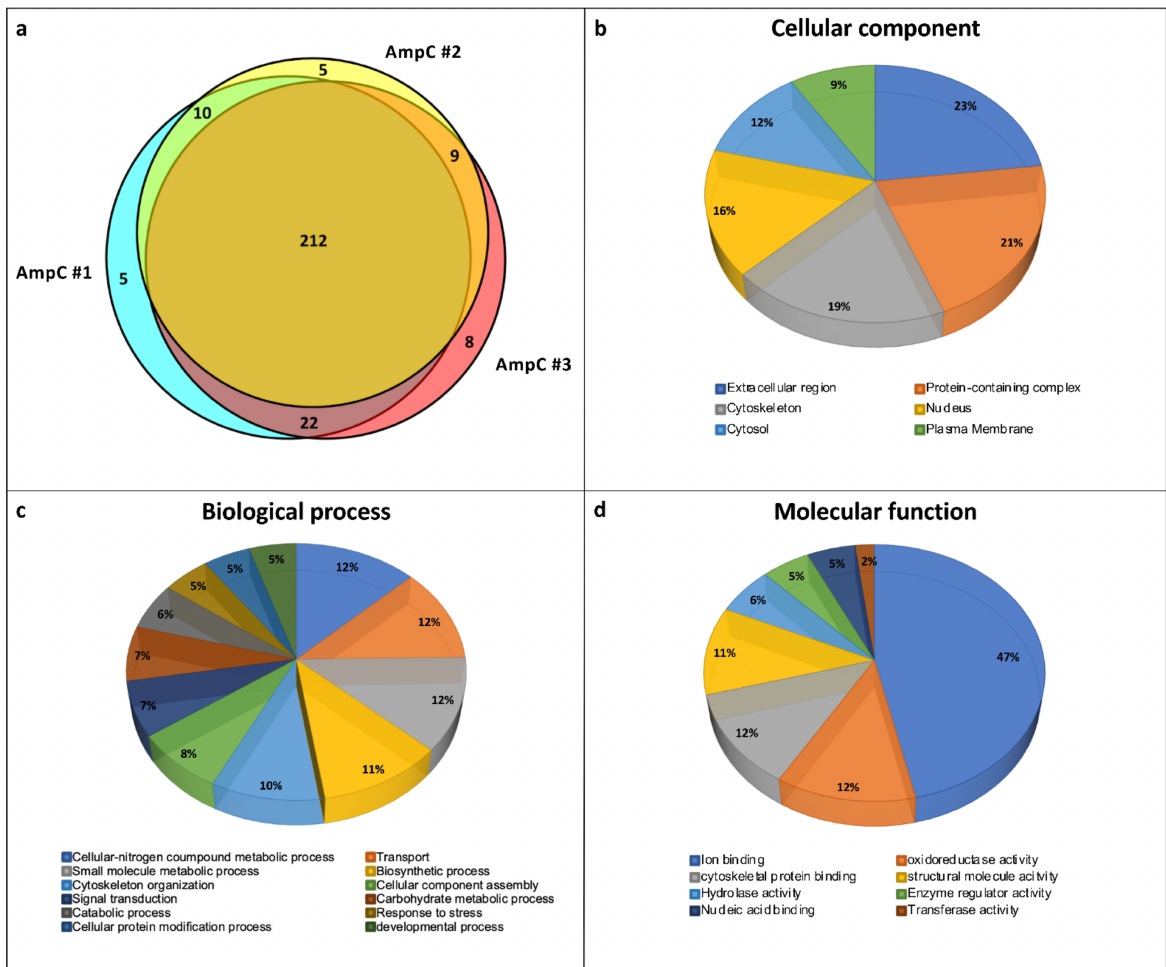
Figure 6. Proteomic analysis. ( a ) Venn diagram of total proteins identified in each of three biological replicates (#1, #2 and #3). The proteins identified in at least two biological replicates (349) were used for further analysis. ( b – d ) Gene ontology analysis related to cellular component, biological process and molecular function, respectively. The percentage of proteins enriched in each category is